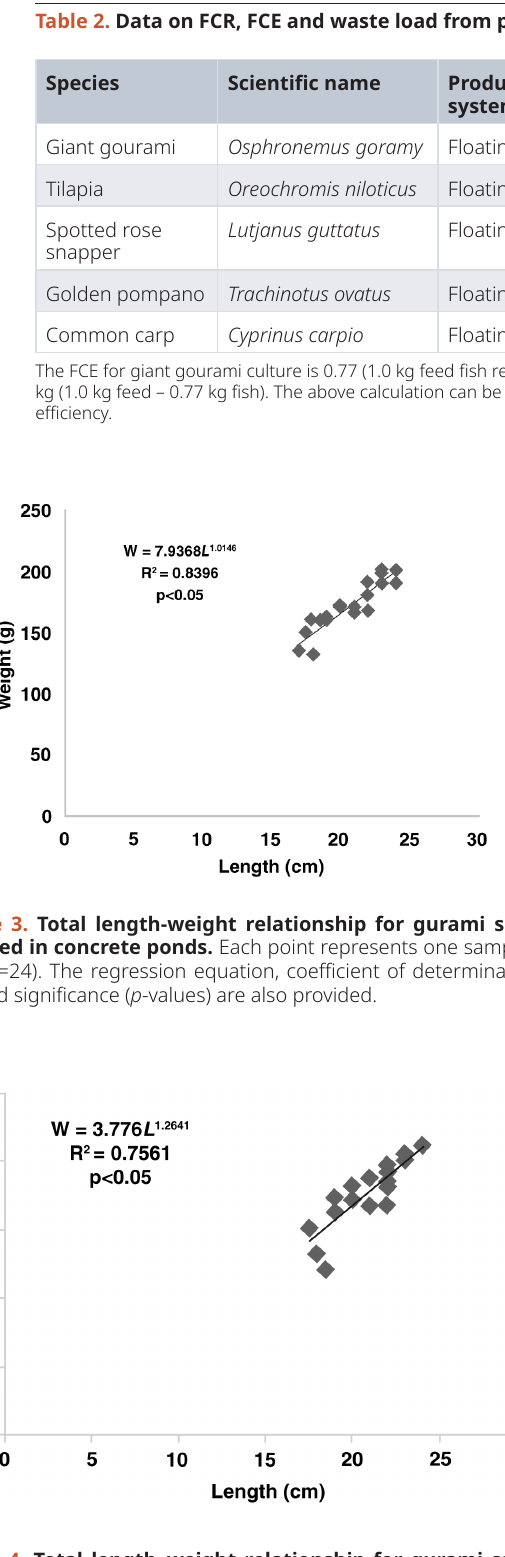
Figure 4. Total length–weight relationship for gurami sago cultured in floating net cages. Each point represents one sampled fish ( N =24). The regression equation, coefficient of determination (R 2 ) and significance ( p -values) are also provided.